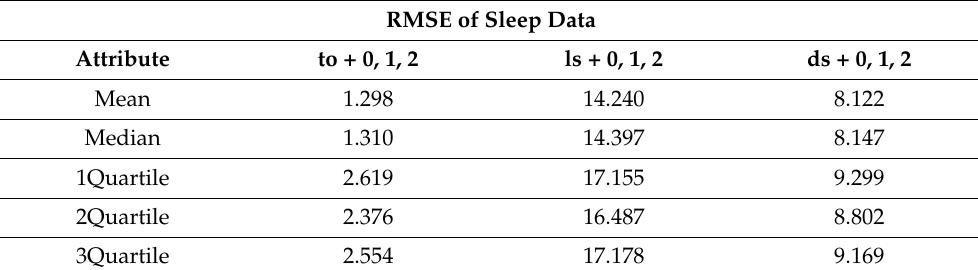
Table 4. RMSE and representative value of sleep